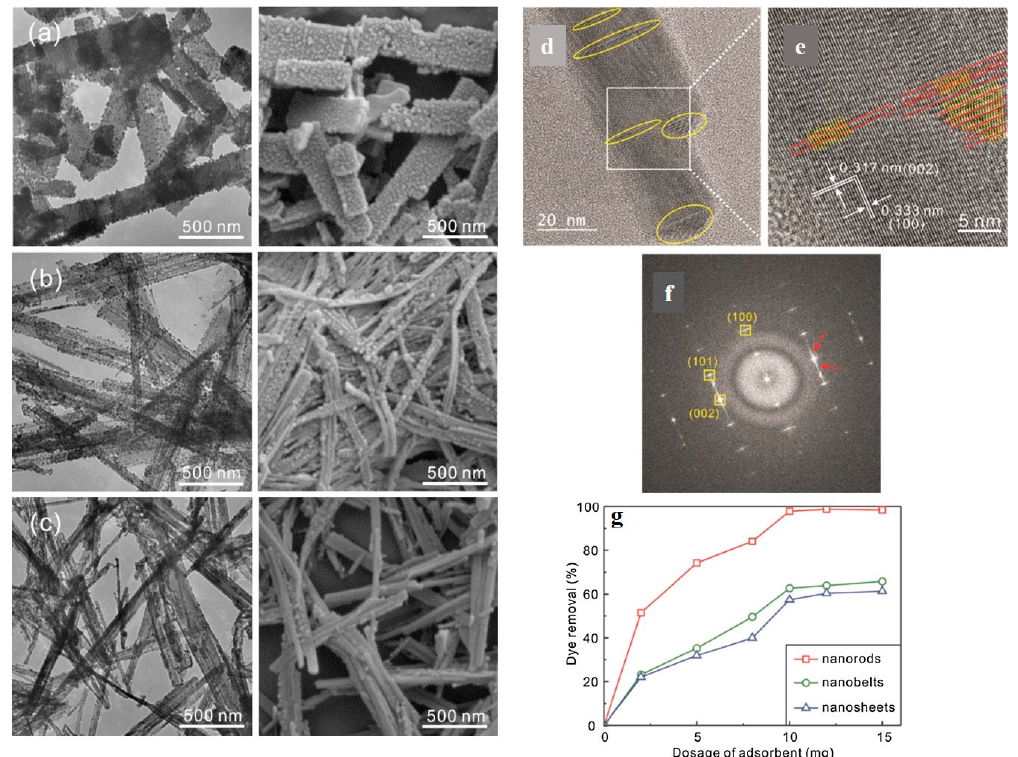
Figure 8. ( a – c ) TEM ( left ) and SEM ( right ) images imply the morphology of the Cu exchanged ZnS nanosheets, nanobelts, and nanorods, respectively. HRTEM images ( d and e ) and FFT pattern ( f ) of a Cu-exchanged ZnS nanorod. In these images ( d and e ), the yellow marks and lines represent the stacking faults and planar defects, respectively. In addition, the red lines ( e ) and arrows ( f ) mark the lattice orientations and defects, respectively. ( g ) RhB removal efficiency of the Cu-exchanged ZnS nano-adsorbents in different morphologies varies depending on the adsorbent concentration. Reproduced with permission [127]. Copyright 2017,